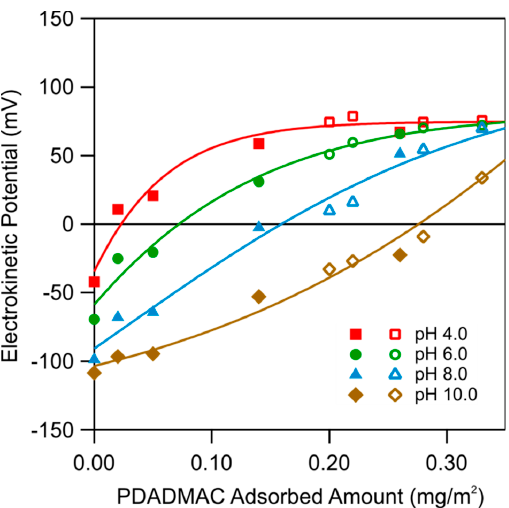
Figure 6. Electrokinetic potential of PDADMAC-functionalized silica surfaces versus the adsorbed amount of PDADMAC. The electrokinetic potential was measured at an ionic strength of 1.0 mM. Full symbols correspond to adsorption conditions at pH 4.0, and the open symbols at pH 10.0. The solid lines serve only to guide the eye.